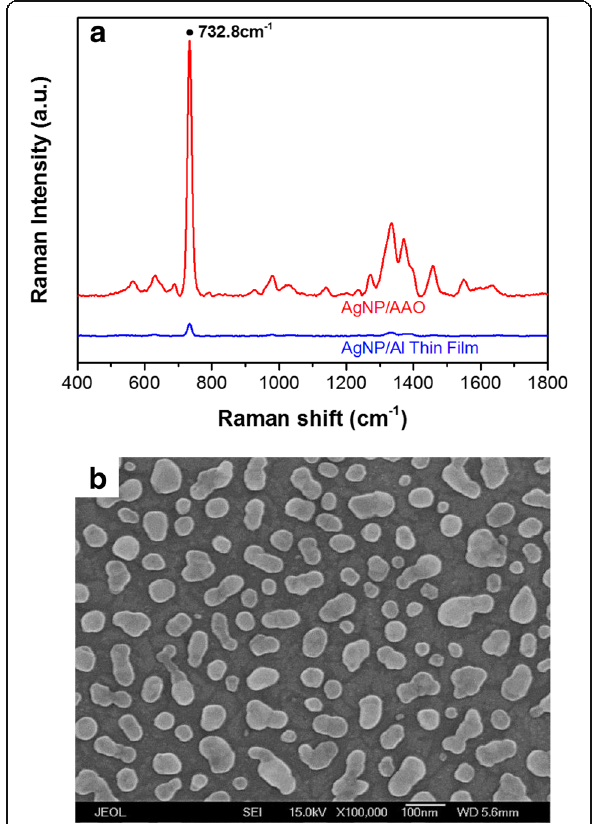
Fig. 4 a SERS spectra of adenine (10 − 4 M) on AgNP/AAO substrate and Ag nanoparticles electrochemically plated on the aluminum (Al) thin film (AgNP/Al) substrate (without AAO template) by averaging seven spectra taken at different spots of the substrate, respectively. b Top-view scanning electron microscope image of AgNP/glass substrate